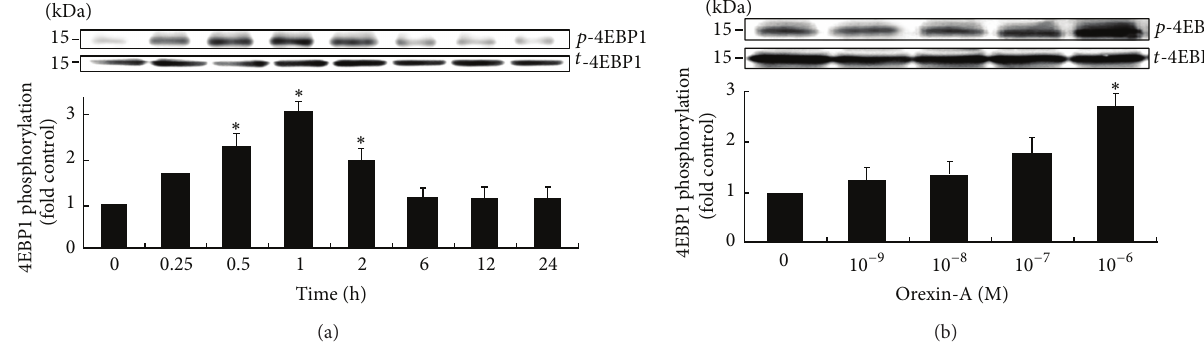
Figure 2: Orexin-A stimulates the 4EBP1 kinase activity in H295R cells. Cells were exposed to orexin-A at concentration of 10 −6 M for 0.25–24 h (a). Another treatment group consisted of 10 −9 M–10 −6 M orexin-A for 1h (b). The expressions of 4EBP1 protein were measured via western blot analysis. Data are presented as mean ± SEM of three independent experiments. Asterisk indicates significant differences as compared to control ( ∗ 𝑃 < 0.05